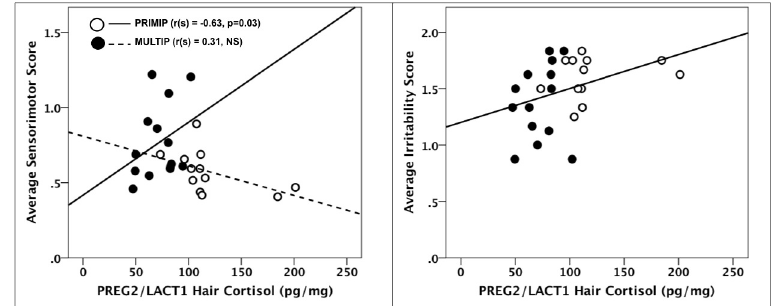
Fig 4. Associations between hair cortisol concentrations in late pregnancy/early lactation and infant neurobehavioral development. PRIMP = primiparous, MULTIP = multiparous.